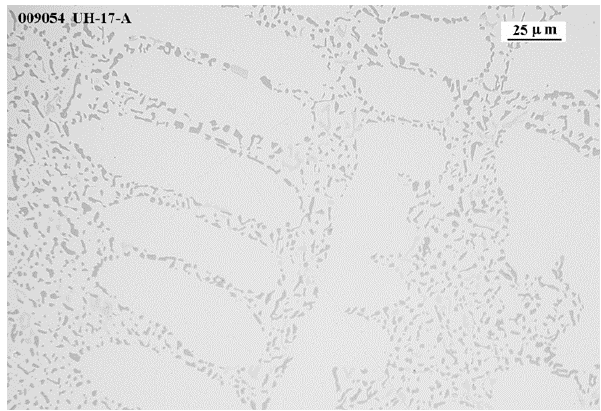
3 Cr and Al x (Fe,Mn,Cr) y Si z phases.